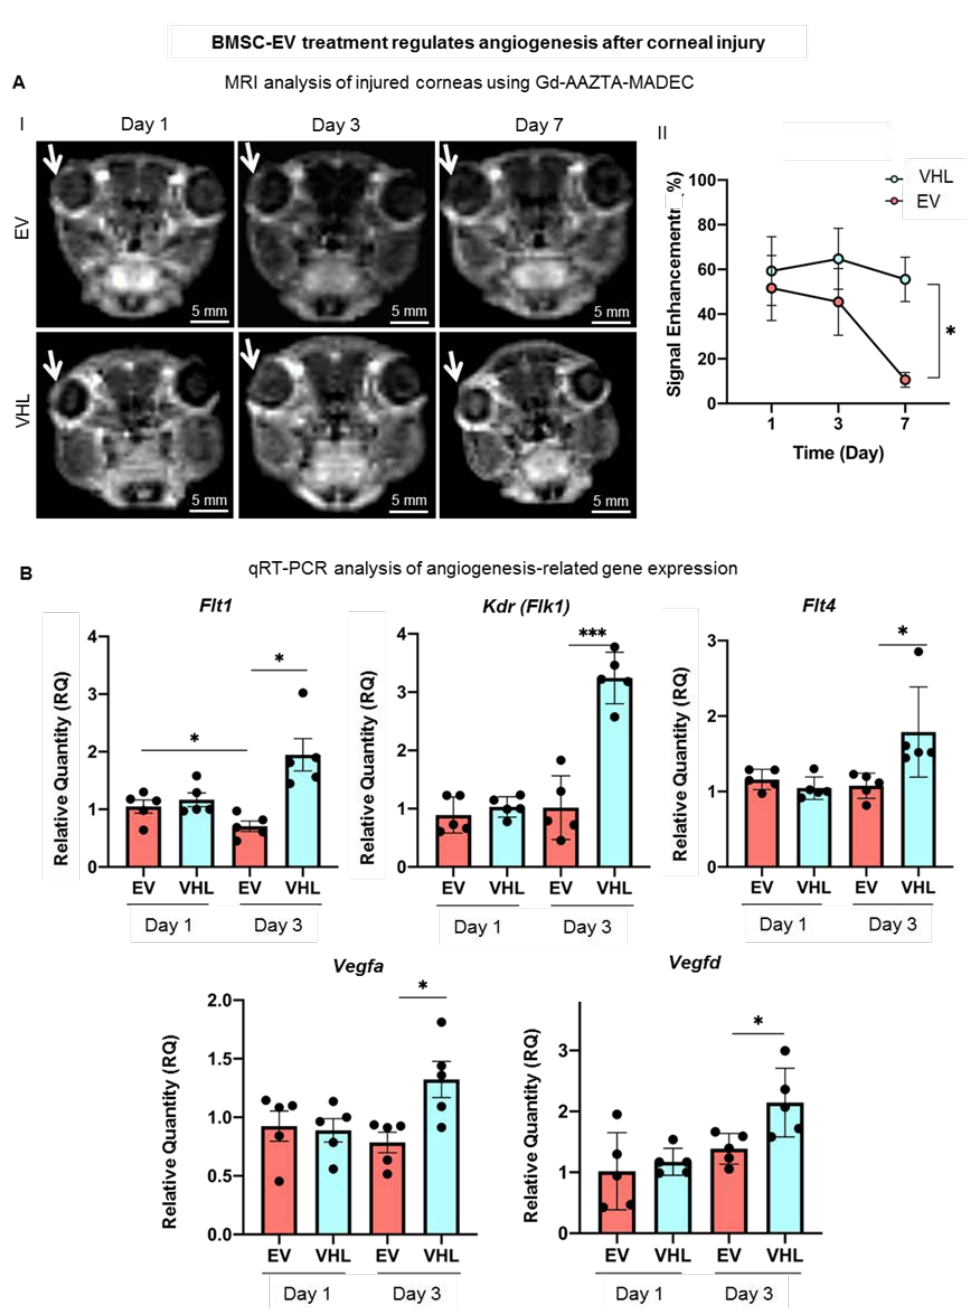
Figure 7. Neoangiogenesis assessment in corneas subjected to alkali burn. ( A ) Representative MRI T1-weighted images of Gd-AAZTA-MADEC-injected mice corneas revealing angiogenic process at days 1, 3 and 7 after BMSC-EV or VHL treatment. White arrow represents the injured area. Graph shows the measured corneal MRI signal enhancement (see Figure S3 for further details) (day 1: n = 6, day 3: n = 6, day 7 n = 5; mean ± SD, * p < 0.05). ( B ) Gene expression analysis of angiogenesis- and lymphangiogenesis-associated factors at days 1 and 3 after EV or VHL treatment in alkali-burned corneas. Data show mean ± SD; n = 5; * p < 0.05, *** p < 0.001. • represents biological